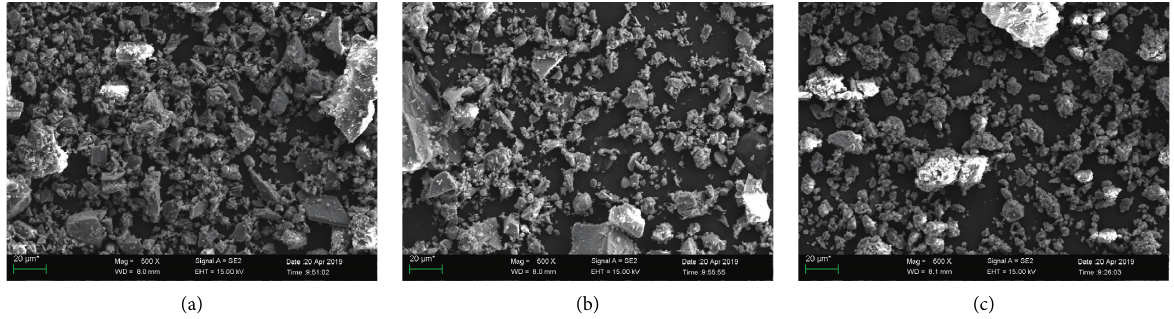
Figure 1: SEM images (500x) of three kinds of powder: (a) cement, (b) FA, and (c) LP.